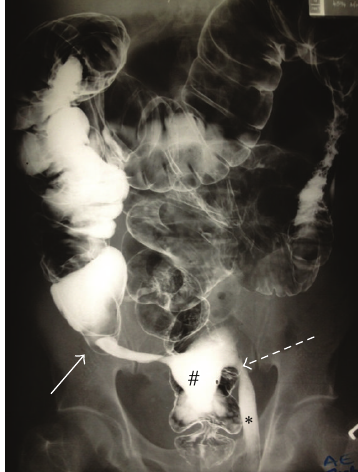
Figure 3: Contrast enema outlining base of appendix (white arrow) and tip of appendix at left inguinal ring (dashed arrow). Note the extravasation of contrast in pelvis (indicated by #) and in the left inguinal canal (indicated by ∗ ).